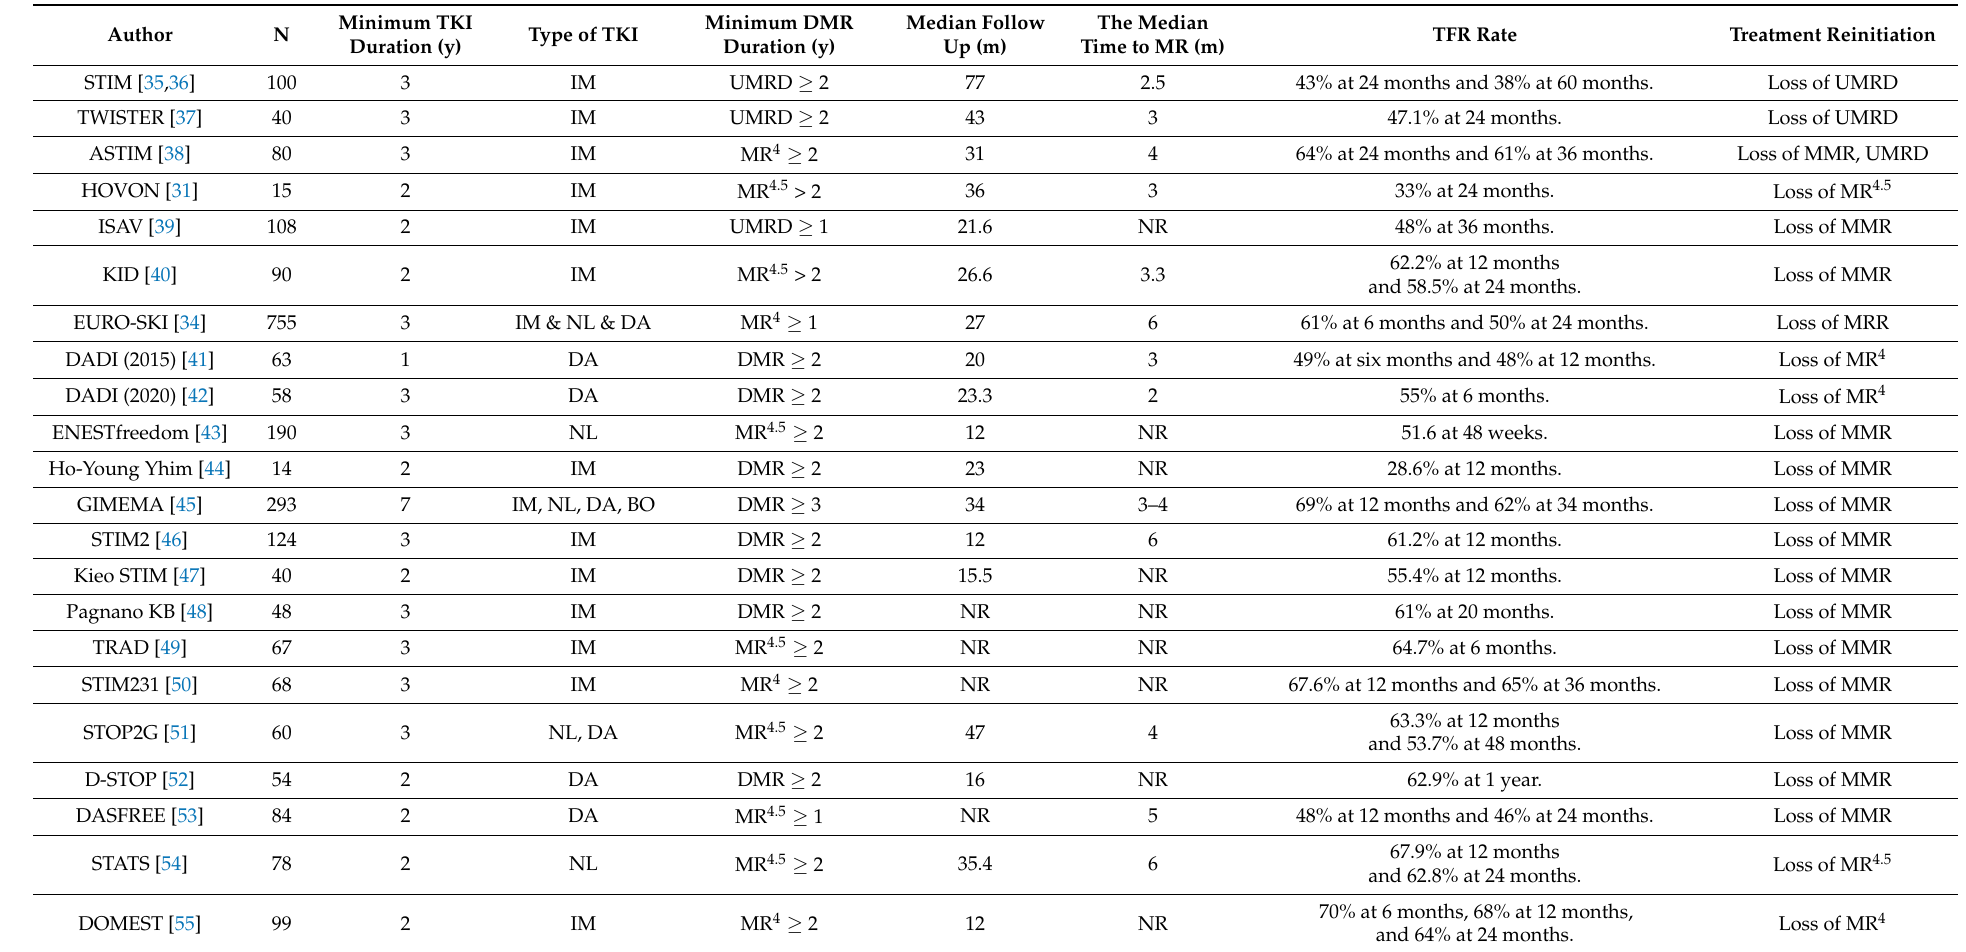
Table 1. Characteristics of trials discontinuing